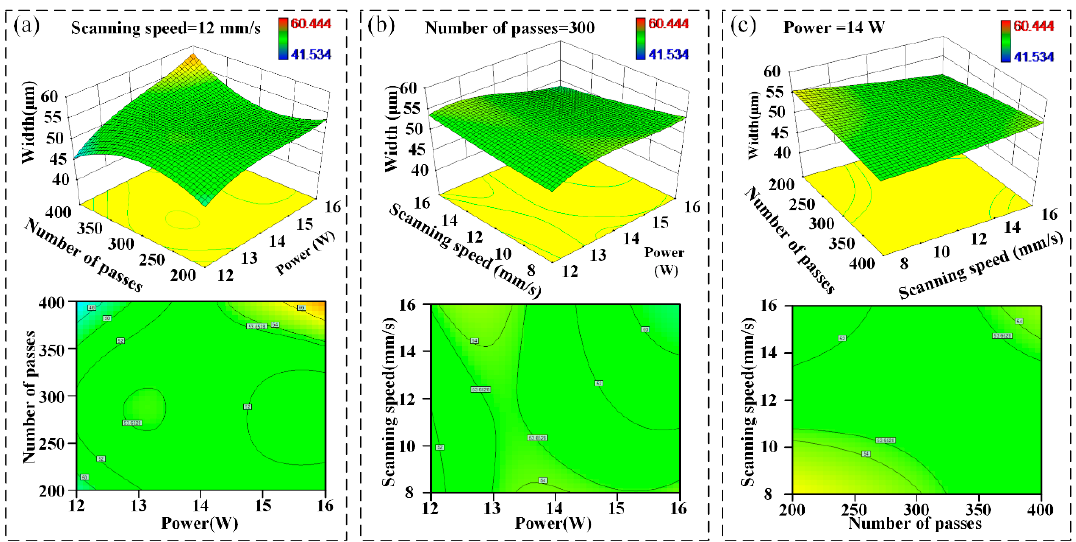
Figure 11. Variations of width with different laser process parameters: ( a ) effects of number of passes and power on width; ( b ) effects of scanning speed and power on width; ( c ) effects of scanning speed and number of passes on width.